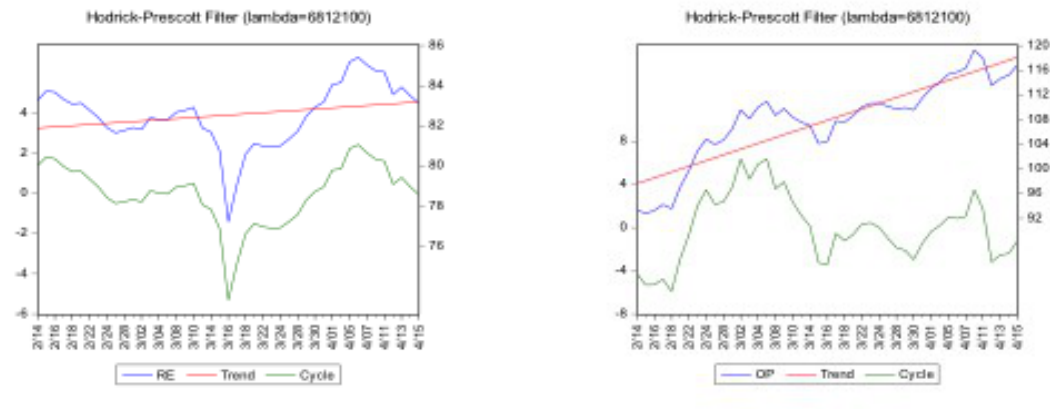
Figure 5. HP filter trend decomposition results of the trends of yen exchange rate and international crude oil